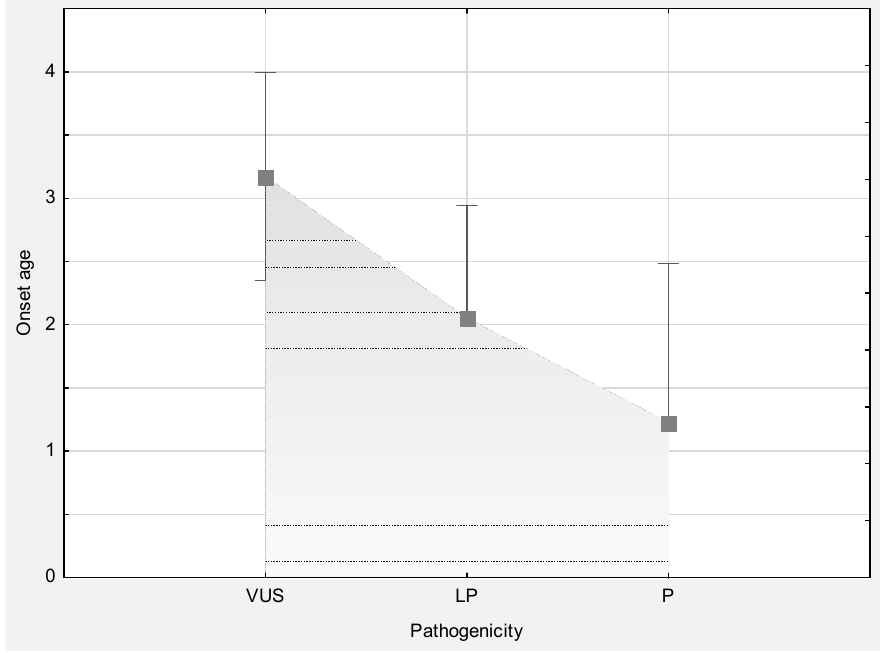
Figure 2. Significantly different age at onset between groups of patients stratified according to variant annotation.